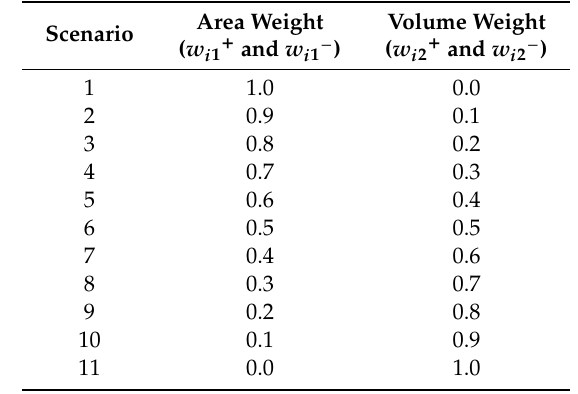
Table 2. Weights for the two objectives.